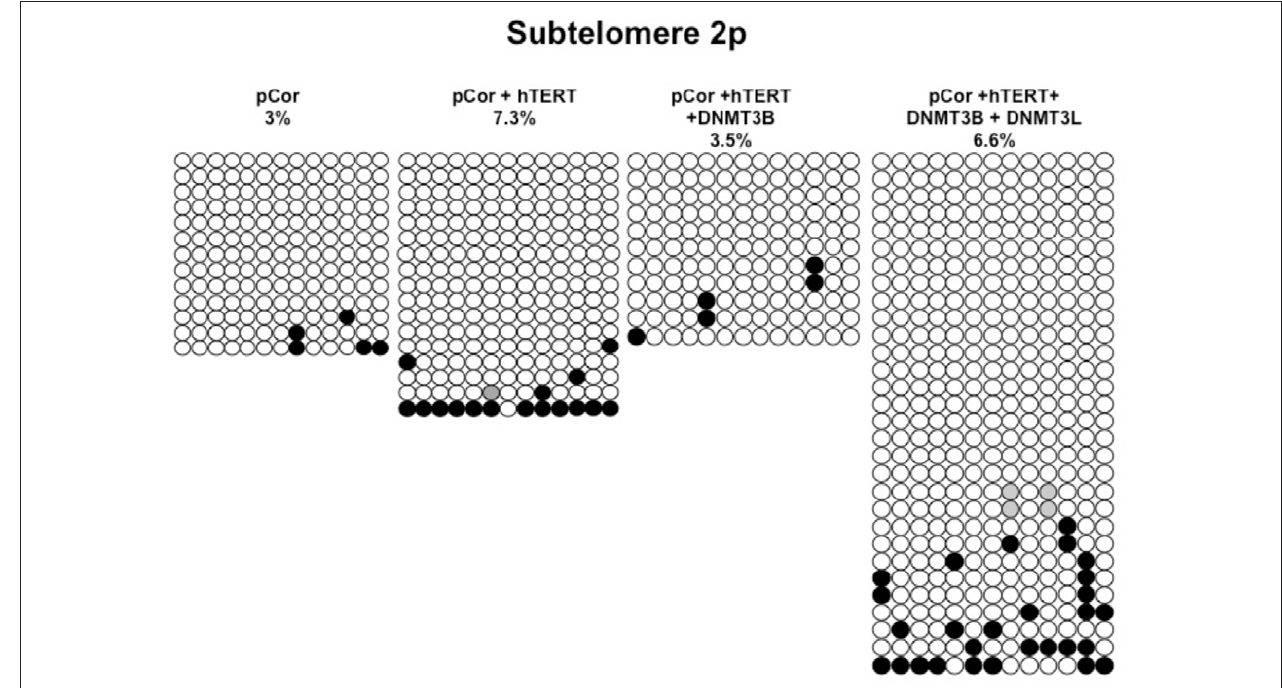
FIGURE A2 | Bisulfite analysis of subtelomeric region 2p. Bisulfite sequence analysis was carried out for a region in subtelomere 2p in pCor, pCor + hTERT, pCor + hTERT + DNMT3B1 and pCor + hTERT + DNMT3B1 + DNMT3L fibroblasts. The analyzed region contains 13 CpG sites. White circles represent unmethylated CpG